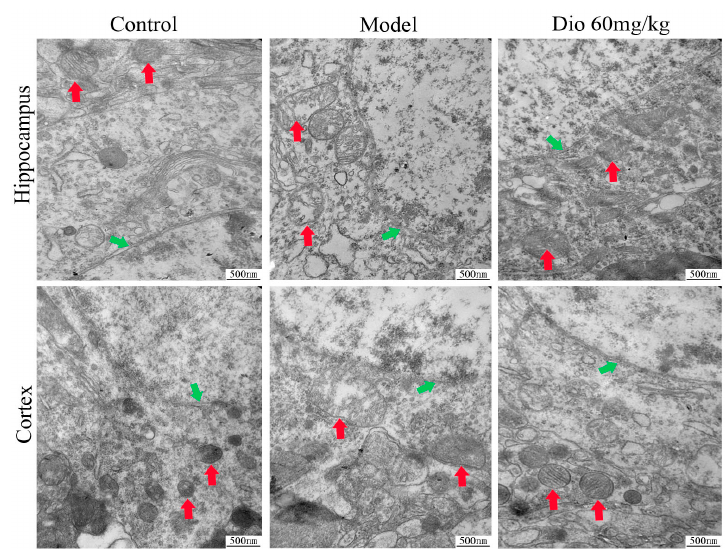
Figure 5. Effects of dioscin on ultrastructure changes in aging brain by transmission electron microscopy (TEM) assay (40,000 × magnification). Nuclear membrane and mitochondria are indicated by green arrows and red arrows,